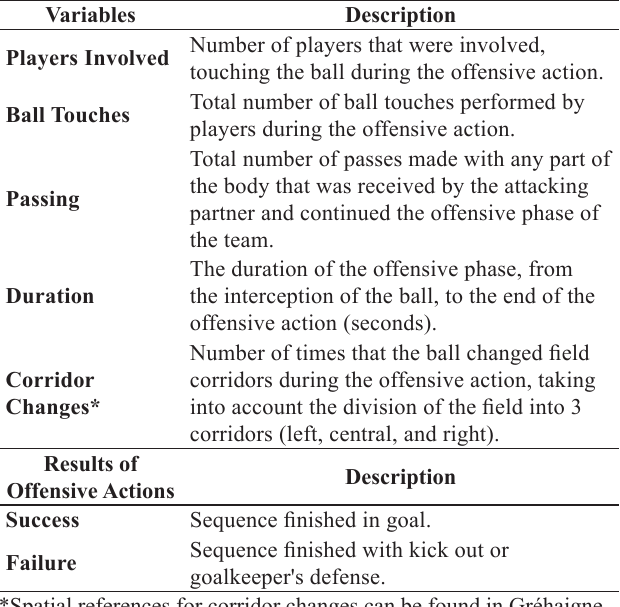
Table 1. Categories of offensive actions and results of the offensive